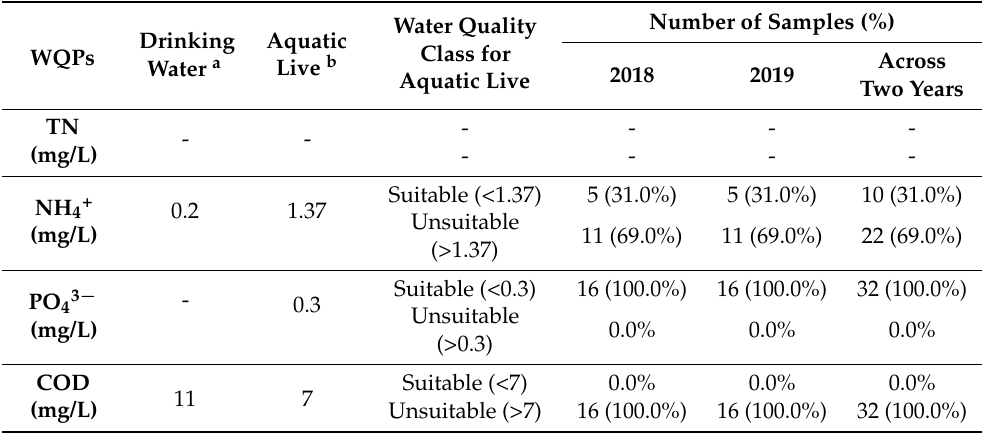
Table 4. Classification of surface water in Lake Qaroun compared to guidelines of drinking utilization and aquatic life protection, according to WQPs over two